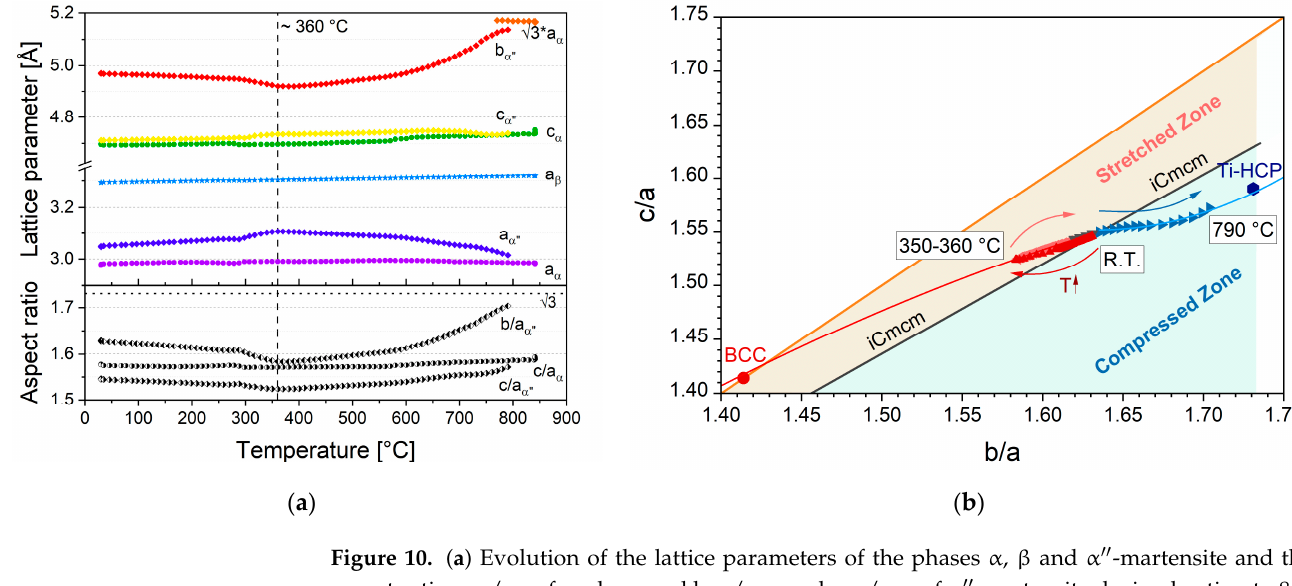
Figure 10. ( a ) Evolution of the lattice parameters of the phases α , β and α″ -martensite and the aspect ratios c α /a α of α -phase and b α″ /a α″ and c α″ /a α″ of α″ -martensite during heating to 840 °C (dashed line representing the temperature at the turning point of lattice parameter evolution); ( b ) Transition path of orthorhombic unit cell from i Cmcm (= ideal orthorhombic structure according to [16]) to BCC (stretched- Cmcm ) and Ti-HCP (compressed- Cmcm ) visualized based on the aspect ratios b α″ /a α″ and c α″ /a α″ of α″ -martensite during continuous heating to 840 °C with polynomial trendlines based on the approach by [16].